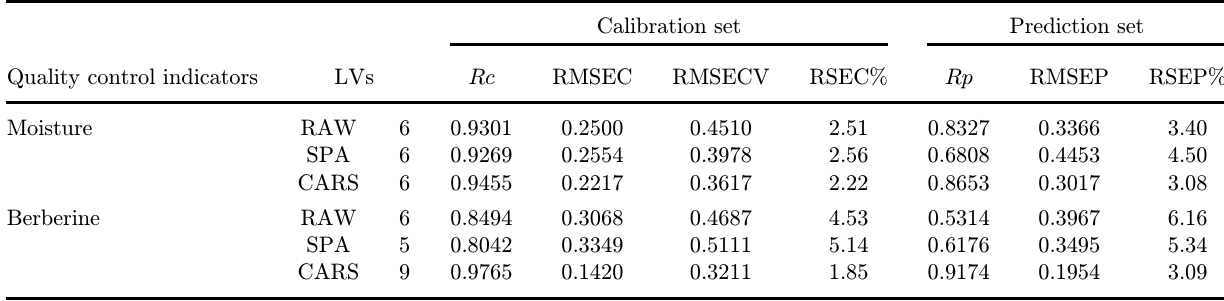
Table 2. Modeling results for single species model of CR.